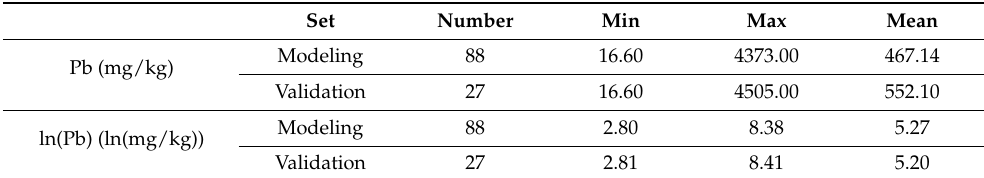
Table 3. Statistics of modelling and validation samples.